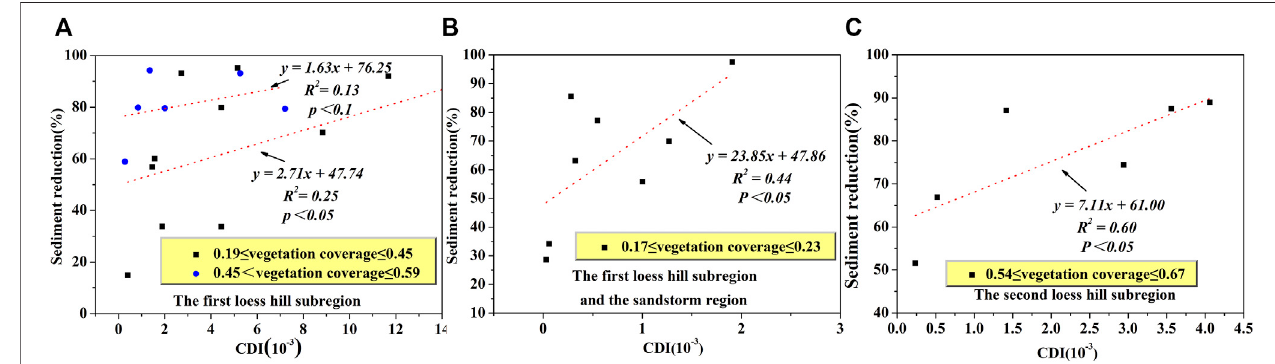
FIGURE 7 | Relationships between the CDI and sediment reduction in the (A) fi rst loess hill subregion, (B) fi rst loess hill subregion and sandstorm region and (C) second loess hill subregion.